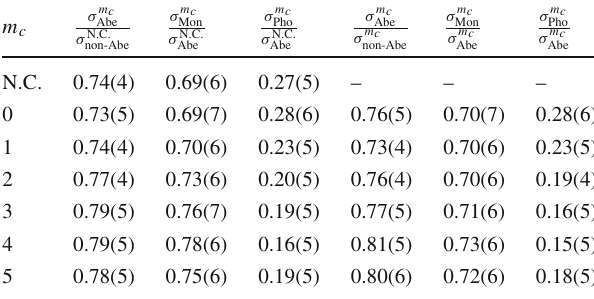
Table 2 The ratios of the string tensions of the non-Abelian σ non-Abe , Abelian σ Abe , monopole σ Mon , and photon σ Pho . The lattice is V = 16 3 × 32 of β = 6 . 0000. The superscripts N. C. and m c represent the computed results of the normal configuration and magnetic charges m c , respectively. The string tensions of the Abelian, monopole, and photon are determined when the size of the temporal direction of the Wilson loop is at T / a = 6 , the fitting range is R I / a = 1 − 8 , and one-hundred diagonalized configurations for each type of configuration are used for these calculations m